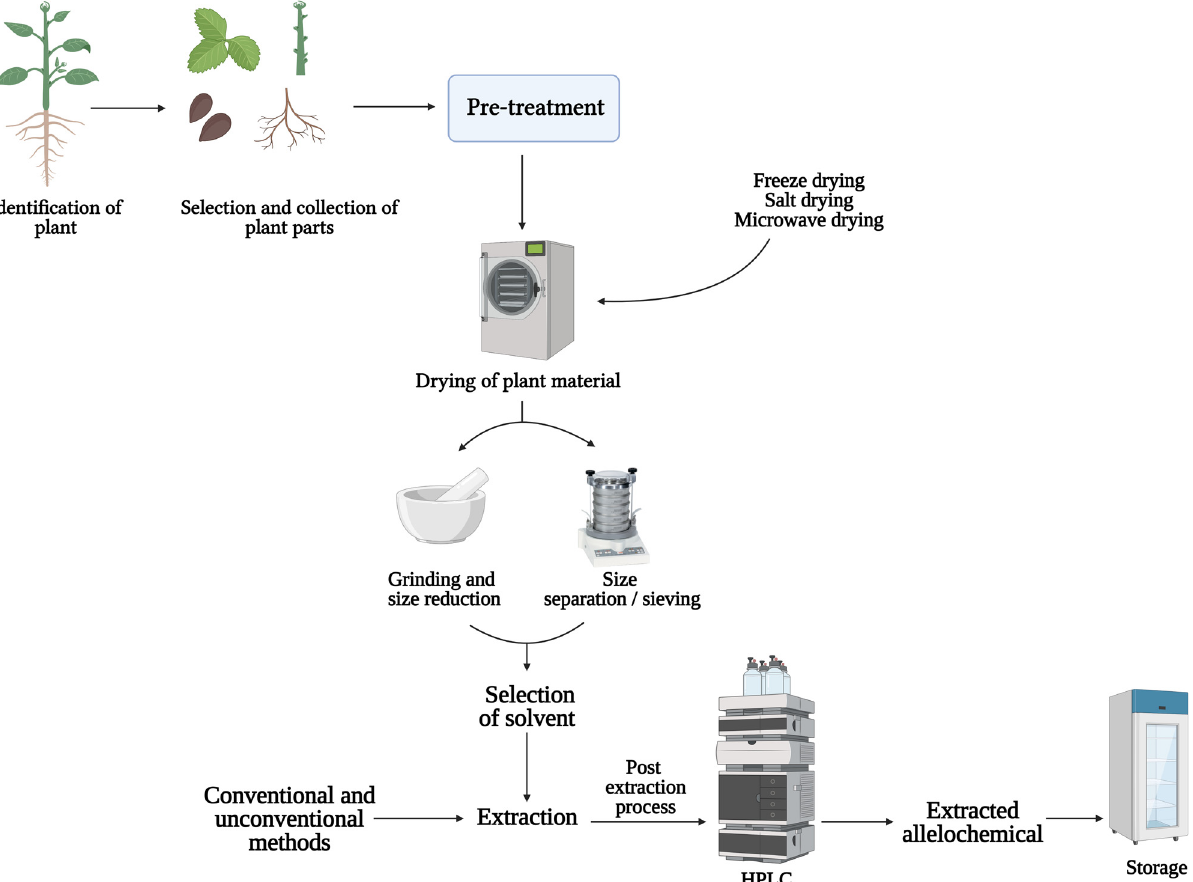
Figure 5: Flow chart of the extraction of allelopathic compounds from plants and